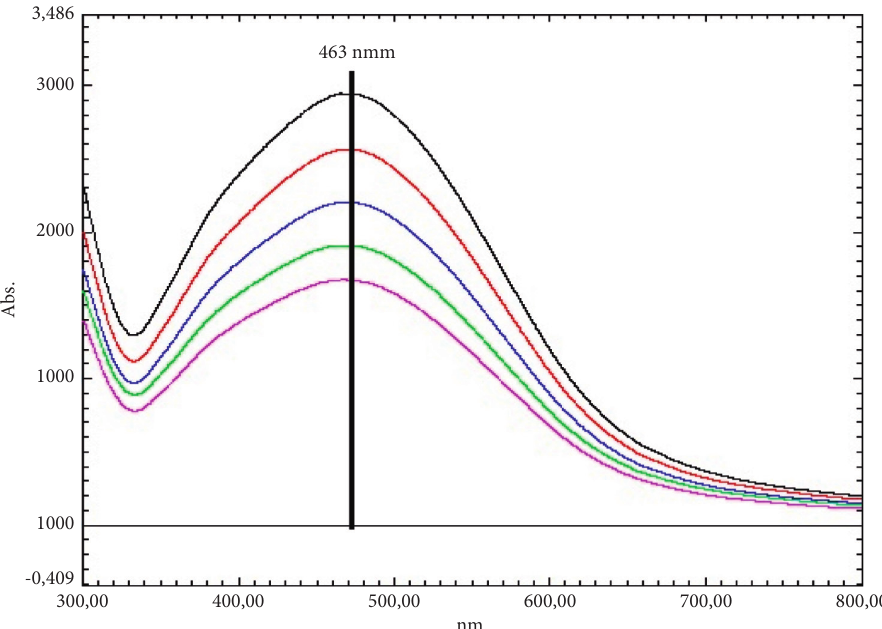
Figure 1: UV-Vis showing the formation and presence of AgNP spectrophotometer data.